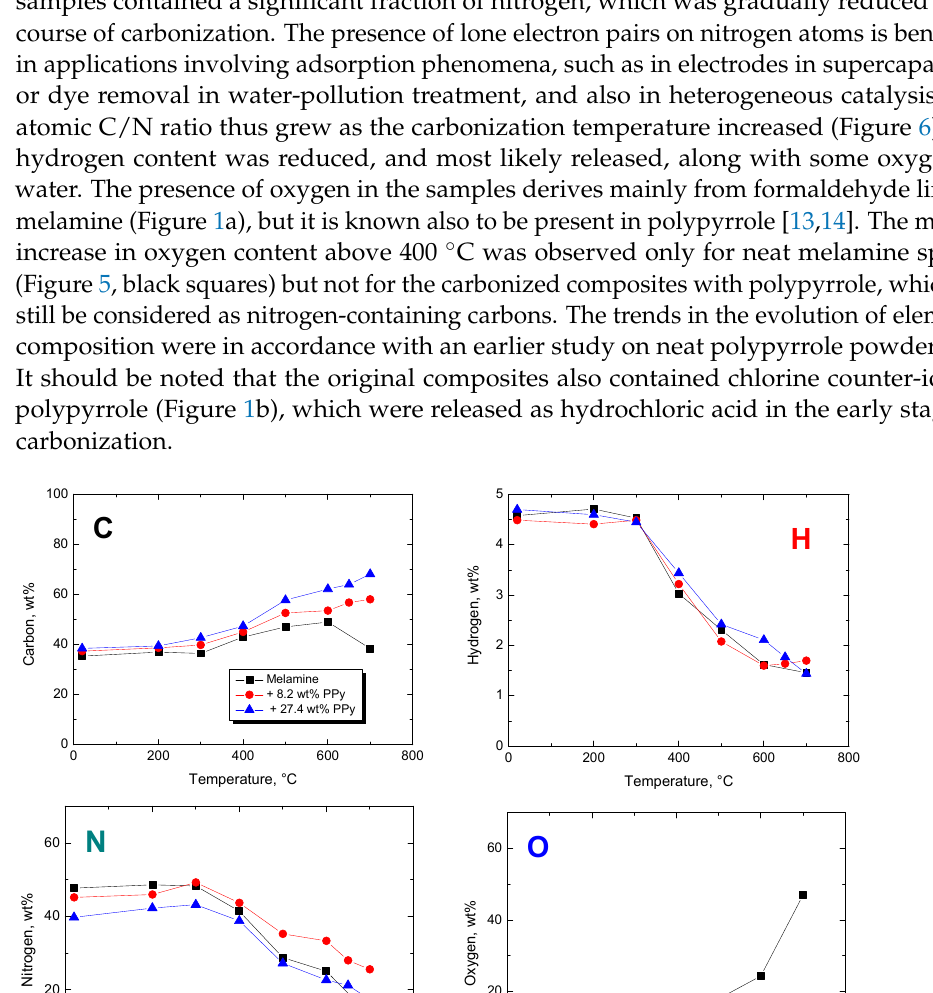
Figure 4. Micrographs of polypyrrole-coated melamine sponge ( a ) before, and ( b ) after carboniza- tion at 650 °C taken at lower ( left ) and higher magnification ( right ).